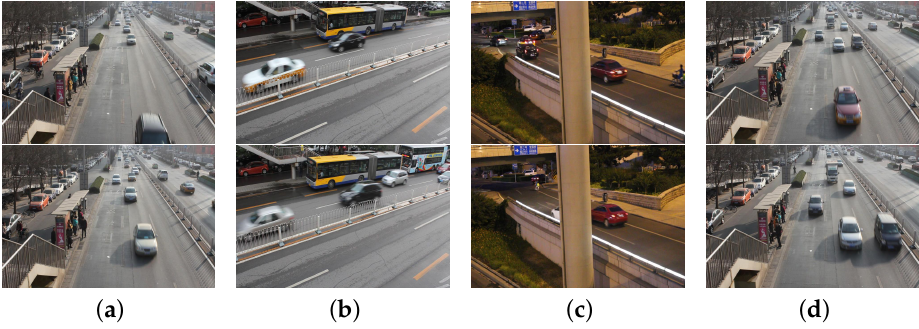
Figure 13. Traffic scene images of UA-DETRAC data set. ( a , b , d ) show the traffic scenes in daytime conditions. ( c ) shows the traffic scenes on the viaduct under night